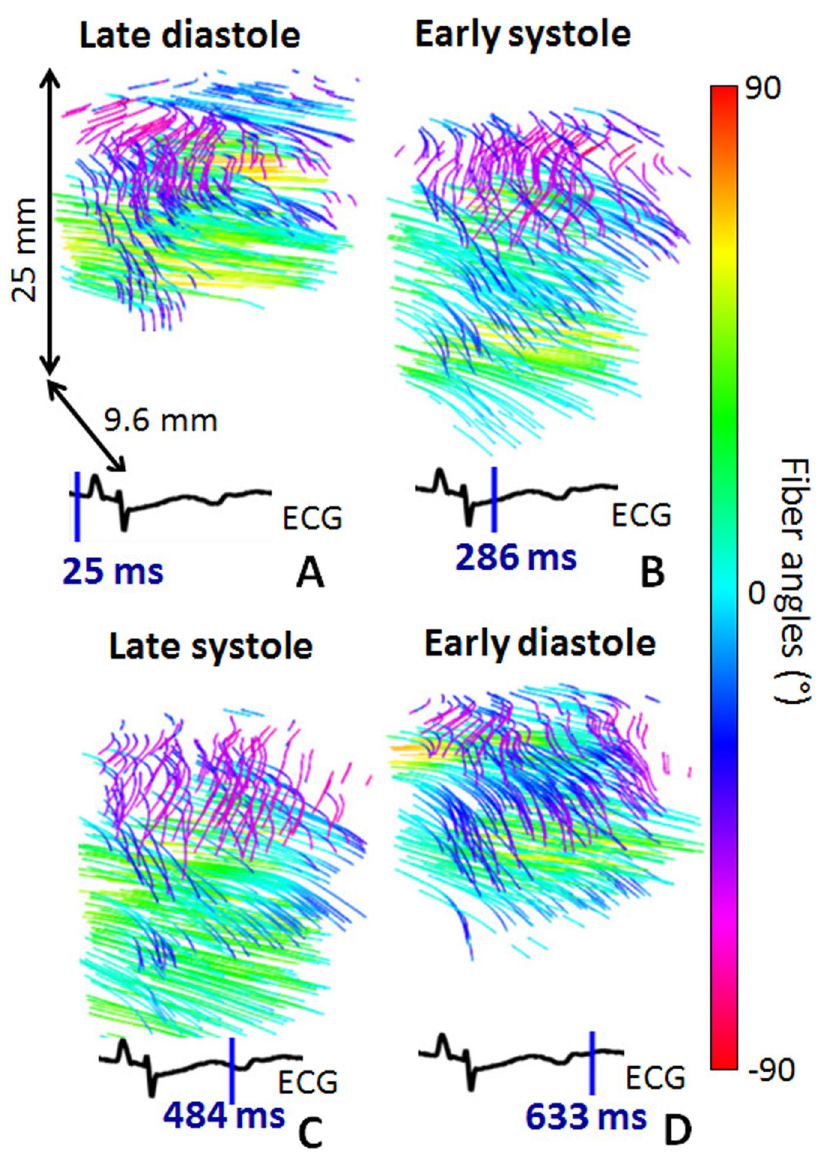
Figure 4. In vivo 3D-BTI. 3D representation of fibers orientation in the left ventricle of an open-chest sheep at four different moments of the cardiac cycle (i.e. ( A ) Late Diastole, ( B ) Early Systole, ( C ) Late Systole, ( D ) Early